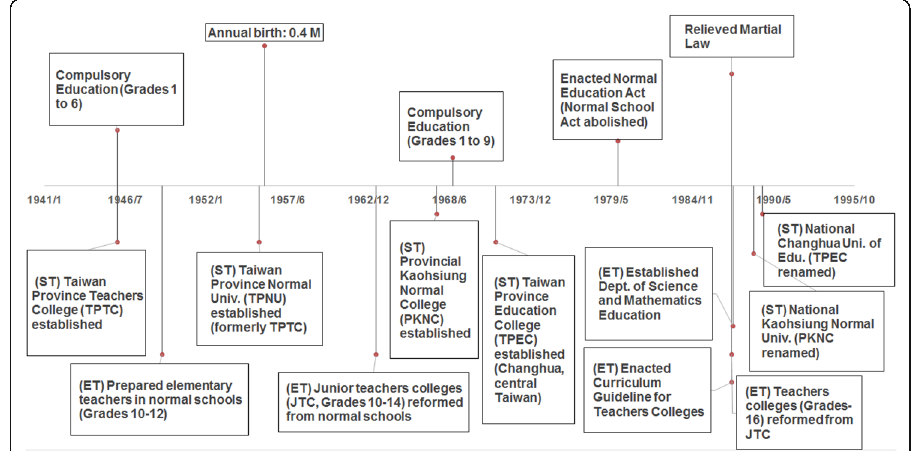
Fig. 1 The historical landmarks during the distance past stage (DPs): 1945 – 1993 (ST: secondary teacher; ET: elementary